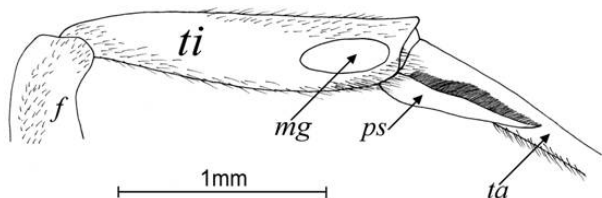
Fig 3 . The Metatibial Ggland on the posterior leg of Bothroponera crassior . f , femur; ti , tibia; mg , metatibial gland; ps , pectinate spur; ta ,